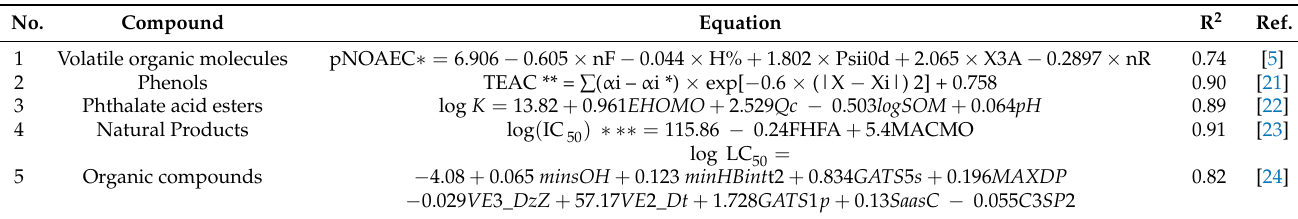
Table 1. QSAR models for common toxicity